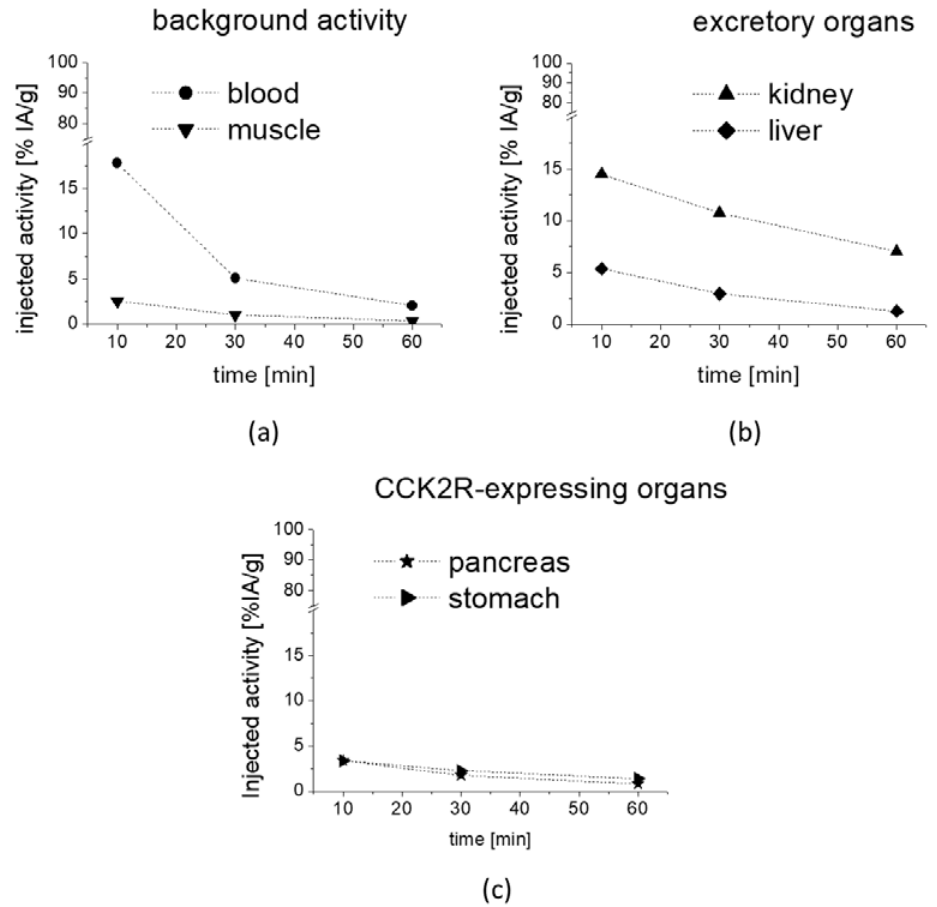
Figure 7. Uptake values in selected tissues as obtained from metabolic biodistribution studies with [ 177 Lu]Lu- 1 in BALB/c mice at 10, 30 and 60 min p.i.: ( a ) background activity in blood and muscle, ( b ) excretory organs kidney and liver as well as ( c ) CCK2R-expressing pancreas and stomach. Values are expressed as % IA/g. Table 2. Biodistribution profile of [ 177 Lu]Lu- 1 in BALB/c mice after 10 min, 30 min and 1 h p.i. (30–40 MBq, 0.8 nmol). Values are expressed as % IA/g.